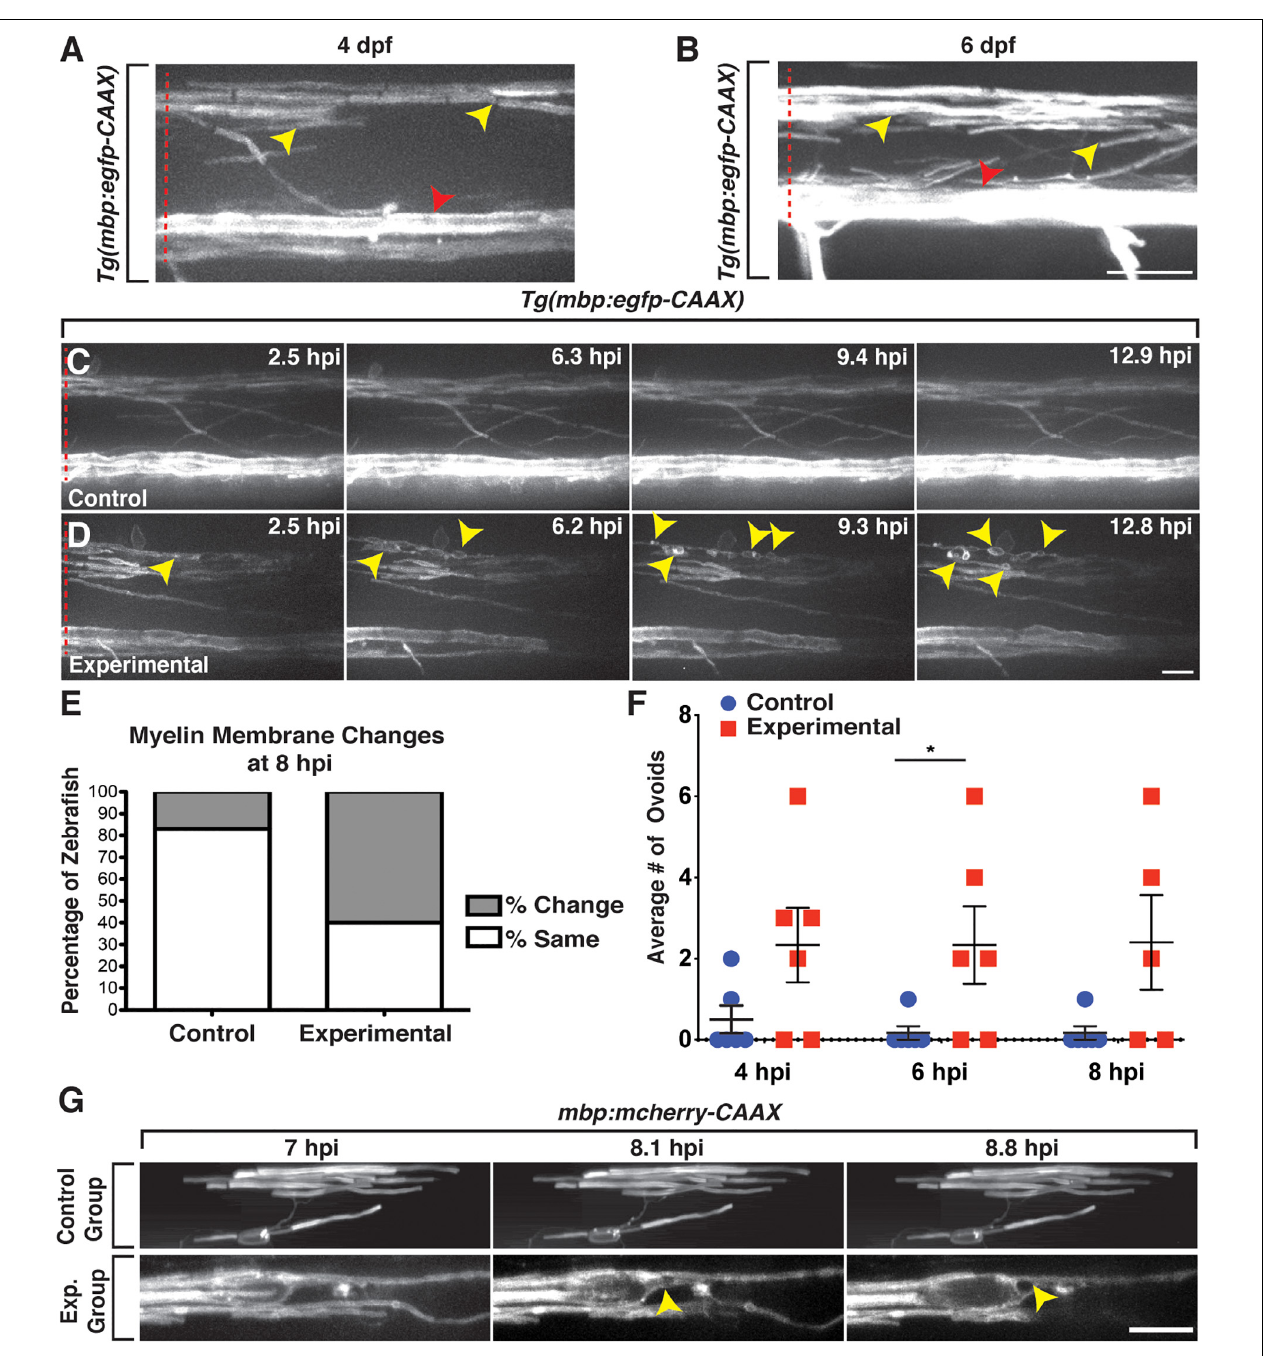
FIGURE 3 | mbp + membrane changes are observed following exposure to lysolecithin. All images are lateral views of the spinal cord with anterior to the left and dorsal to the top. (A,B) Expression of mbp:egfp-CAAX appears as sheath-like structures in the dorsal and ventral spinal cords in 4 (A) and 6 dpf (B) zebrafish larvae. (C) Following injection of a control solution into the spinal cord of a 4 dpf mbp:eegfp-CAAX larva, the mbp + membrane sheaths remain unchanged throughout the duration of the time-lapse movie. (D) Following injection of a lysolecithin (experimental) solution into the spinal cord of a 4 dpf mbp:egfp-CAAX larva, the mbp + sheaths dynamically change to form ovoids (arrowheads). (E) Quantification of the percentage of zebrafish with mbp:egfp-CAAX membrane changes at 8 hpi. p < 0.0001; n = 6 control; n = 5 experimental. (F) Quantification of the average number of mbp:egfp-CAAX ovoids observed at 4, 6, and 8 hpi demonstrates an increase in the number of ovoids within the lysolecithin (experimental) group ( n = 6) when compared with the control group ( n = 6). At 6 hpi, * p = 0.0493. (G) Mosaically labeled oligodendrocytes by injection of mbp:mcherry-CAAX. Larvae injected with a control solution (control, top) or lysolecithin (exp. group, bottom) at 6 dpf. Following injection of a control solution (top), the oligodendrocyte remains relatively unchanged throughout the course of the time-lapse movie. In contrast, an ovoid-like structure is observed within the mbp:mcherry-CAAX + oligodendrocyte beginning around 8.1 hpi. Red dashed lines denote the spinal cord. Scale bars, 25 µ